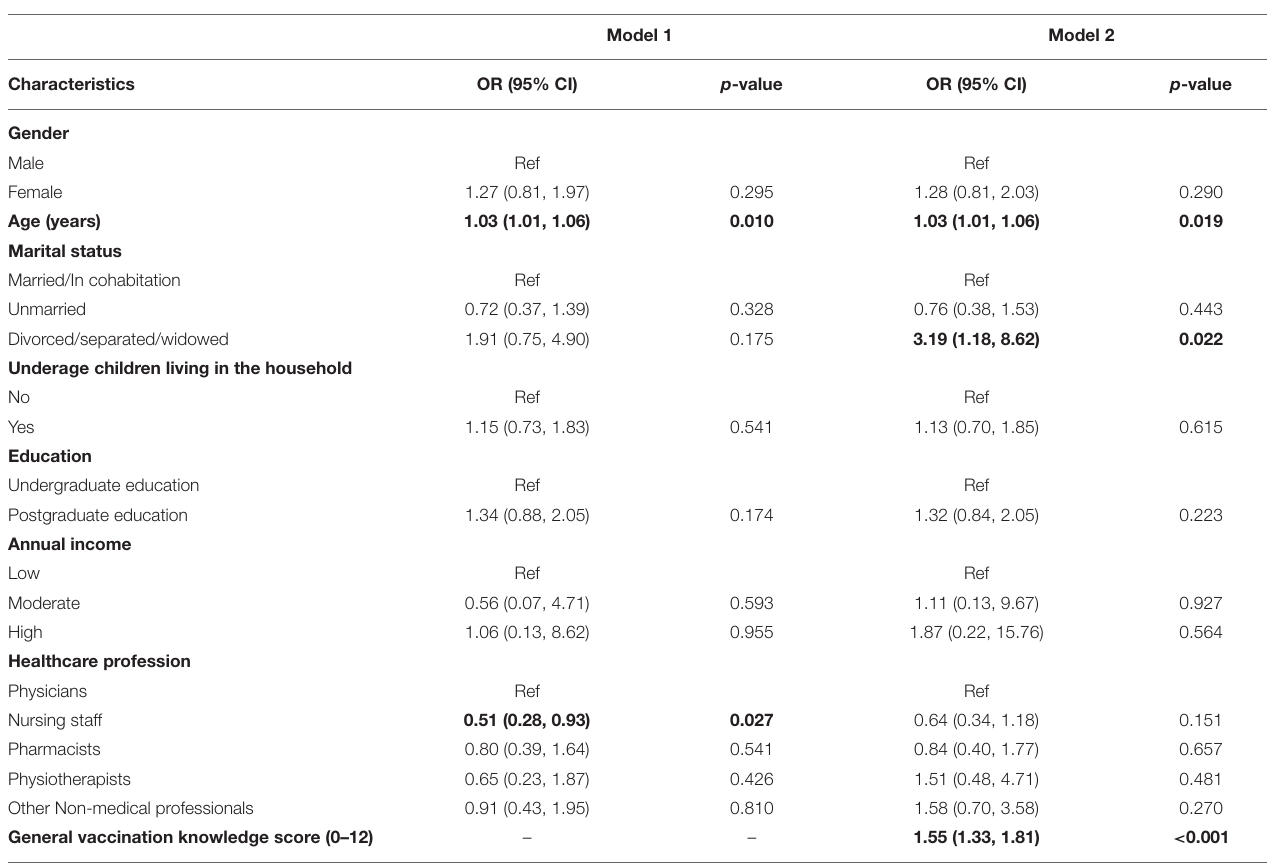
TABLE 4 | Hierarchical logistic regression modeling for sociodemographic and vaccination knowledge score on mandatory vaccination